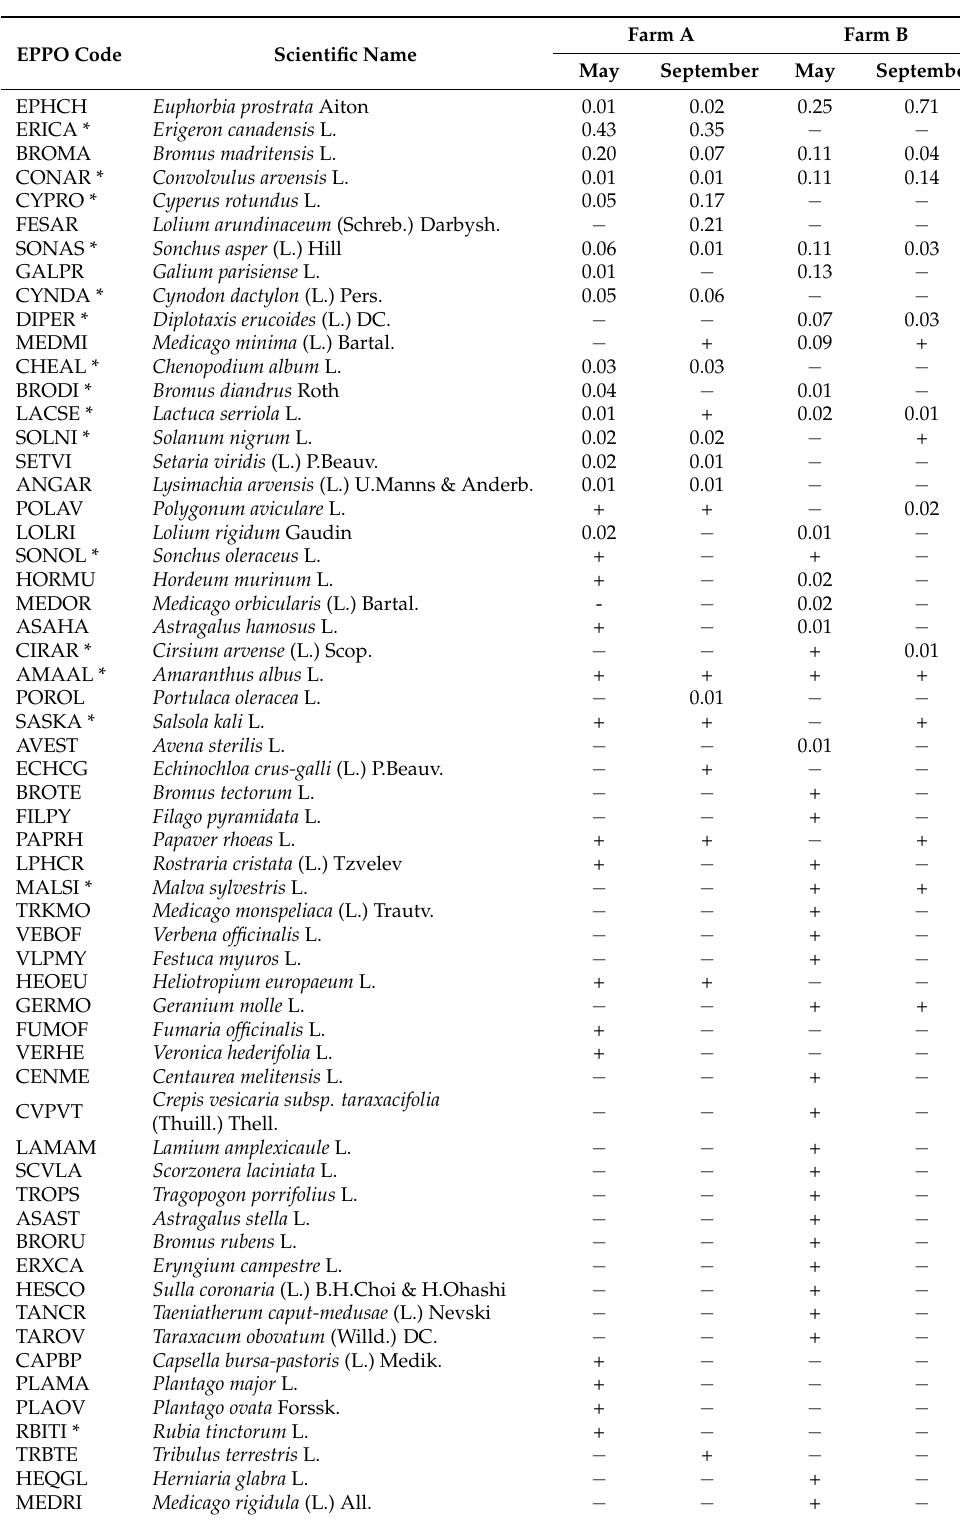
Table 3. List of weeds present on the two study farms during the two sampling dates, May and September (average of the three years 2019 to 2021), ranked in order of highest to lowest relative density. Those species classified as noxious weeds are indicated with an asterisk next to the EPPO code. The + and – signs indicate that the relative density of the species was less than 0.01% (+) or that the species was not found ( −